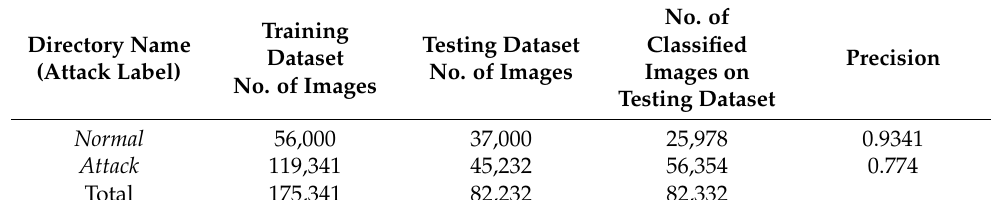
Table 6. Precision of recognized images using ML.NET created model on UNSW-NB15 training dataset employing binary classification.